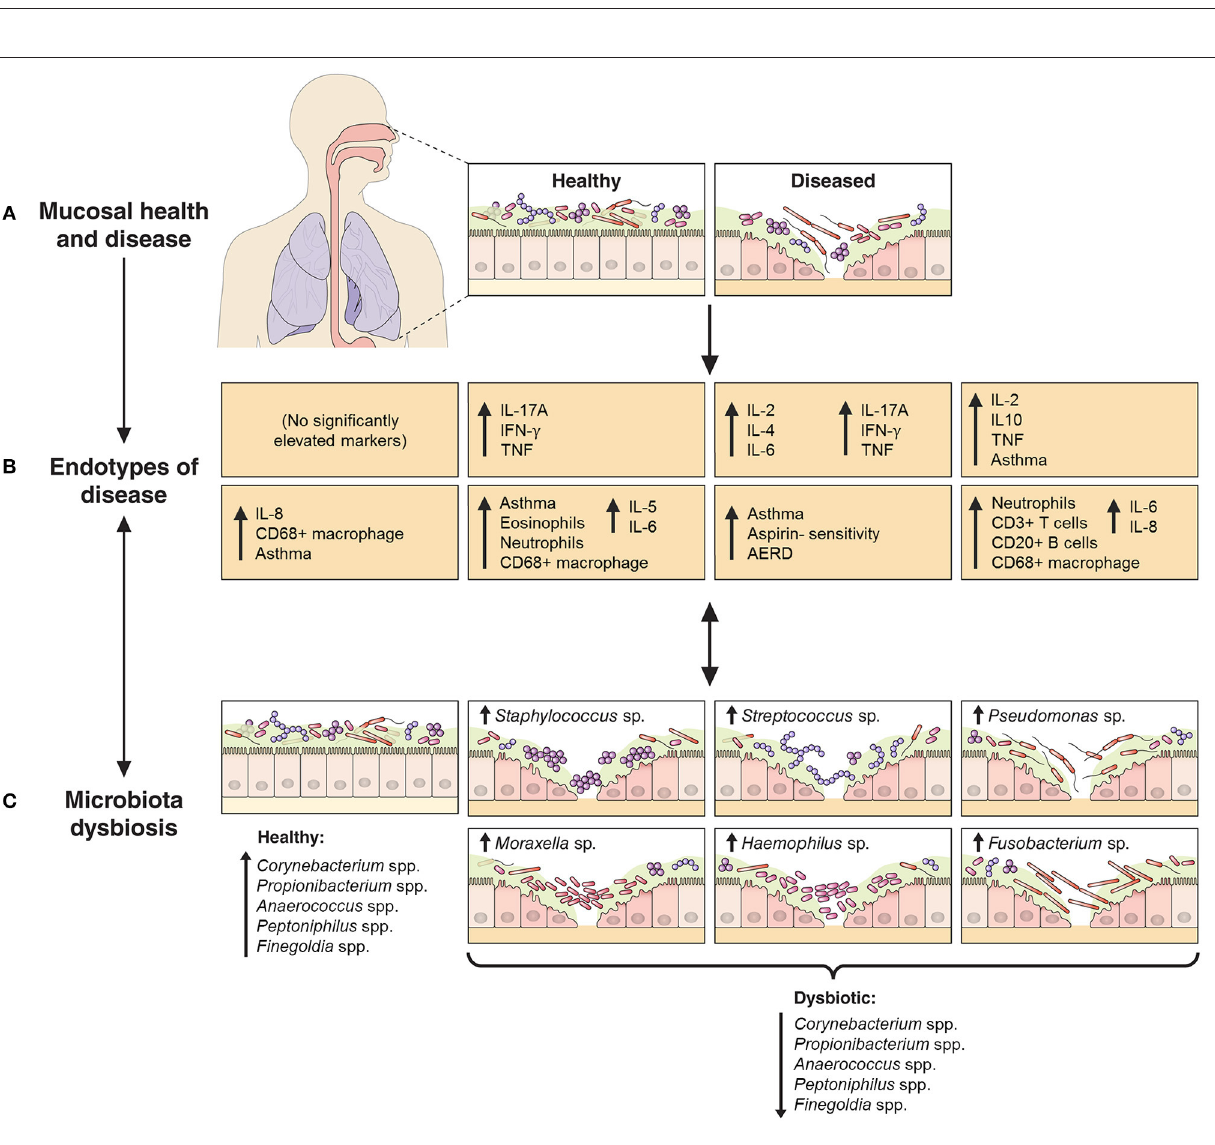
FIGURE 5 | Schematic representation of the relationship between endotypes as sub-types of chronic inflammatory respiratory disease and associated patterns in microbial community dysbiosis (instability and disturbance). The upper panels (A,B) depict the shift from a binary (health vs. disease) approach to define and treat chronic inflammatory mucosal diseases to identifying multiple distinct endotypes (disease variants) on the basis of inflammatory biomarkers. The extent to which aberrant patterns in microbial communities ( C , bottom panels) associate with or drive the underlying inflammatory heterogeneity is of increasing interest. As an example to further provide context, findings from this study of chronic rhinosinusitis subjects have been incorporated into the model: endotypes are represented by the characteristic elevated inflammatory patterns of the eight subject clusters identified in this study, including inflammatory signaling profiles and incidence of comorbidities such as asthma and polyposis. Bacterial community dysbiosis, here characterized by a loss of several “health-associated” taxa (including Staphylococcus spp., Corynebacterium spp., Propionibacterium spp., Anaerococcus spp., Peptoniphilus spp., and Finegoldia spp.) together with dominance by one of several putative pathogens (including particular members of the genera Staphylococcus, Streptococcus, Pseudomonas, Moraxella, Haemophilus , and Fusobacterium ), was associated with elevated inflammatory markers and clinical severity scores. A direct relationship between particular dysbiotic bacterial community types and specific endotypes of CRS remains